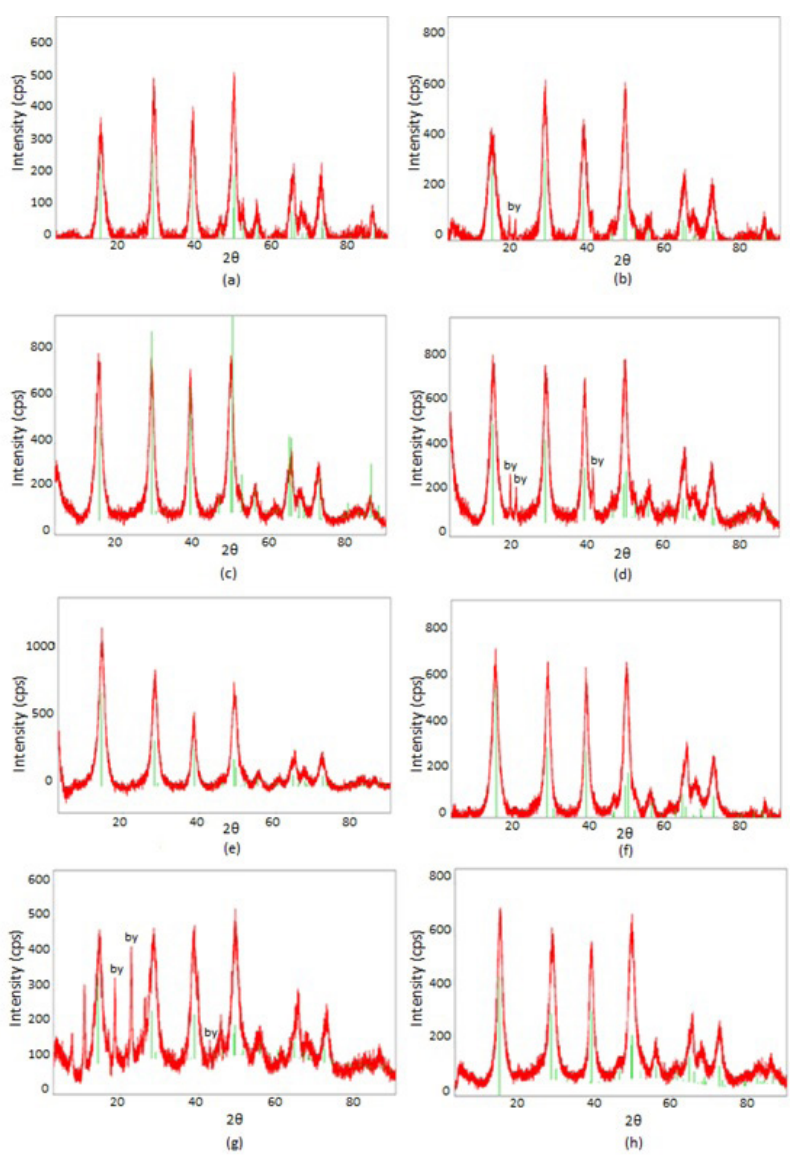
Figure 1. X-ray diffraction data of samples (sample 1 (a), sample 2 (b), sample 3 (c), sample 4 (d), sample 5 (e), sample 6 (f), sample 7 (g), sample 8 (h). by = peaks attributed to bayerite.